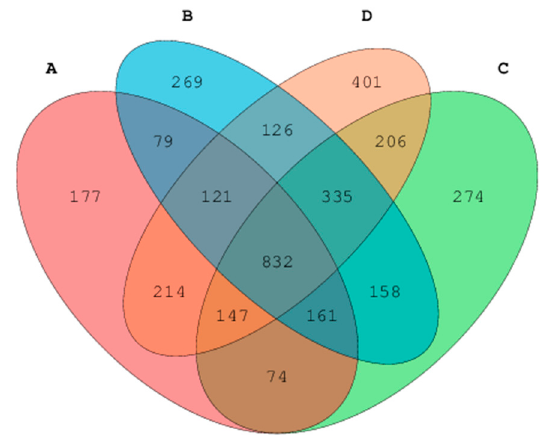
Figure 1. Venn diagram showing shared and unshared operational taxonomic units. A: alfalfa, B: cornstalk, C: rice straw, and D: controls. Note: Each ellipse represents a group of samples corresponding to the three different treatments and the untreated controls.